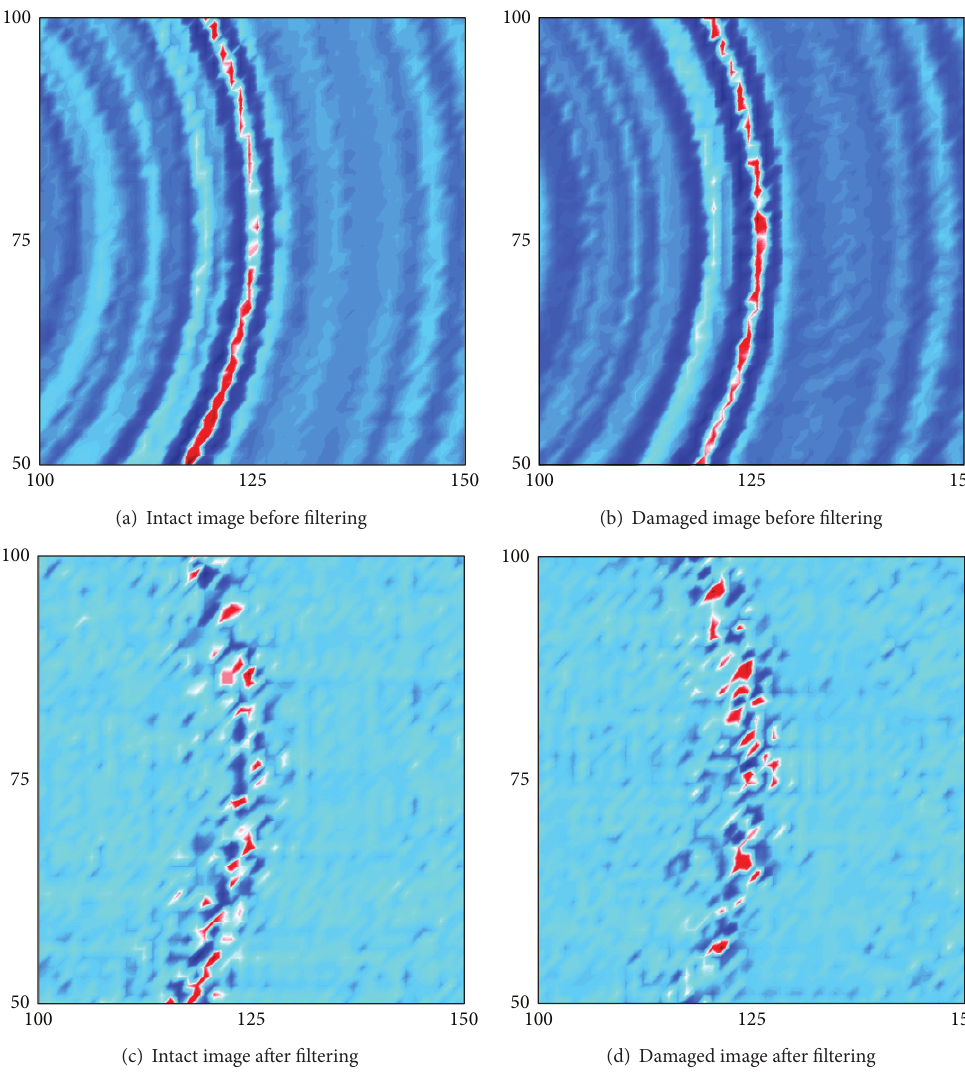
Figure 17: Comparison of UWPI snapshots at 35 𝜇 s for damage case